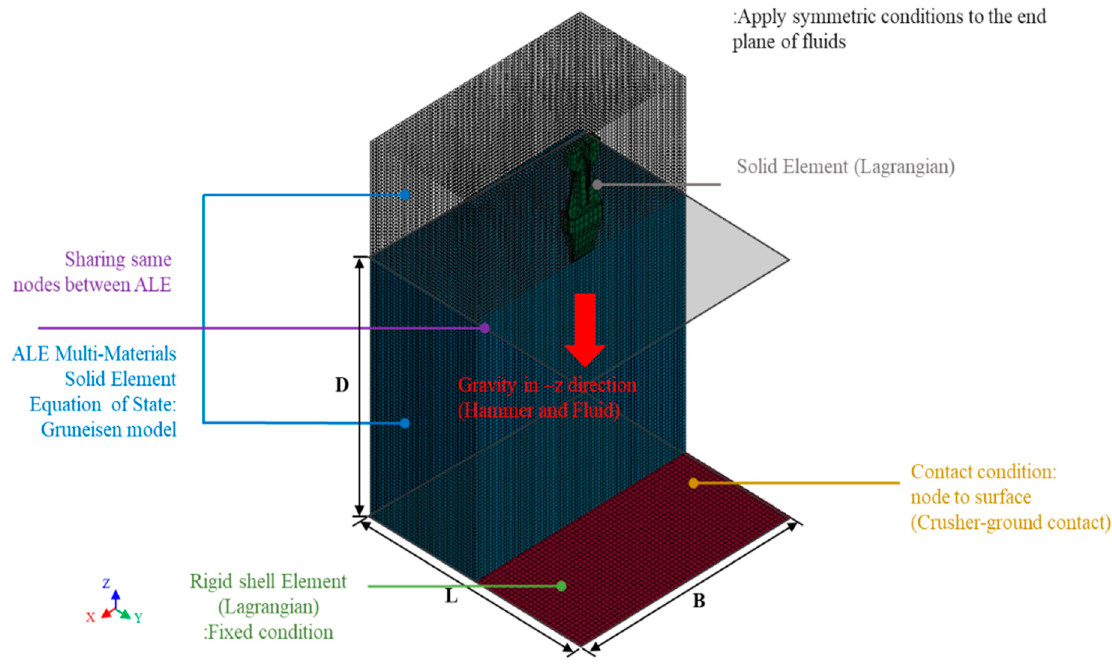
Figure 10. Analysis settings for numerical computation (B-2).